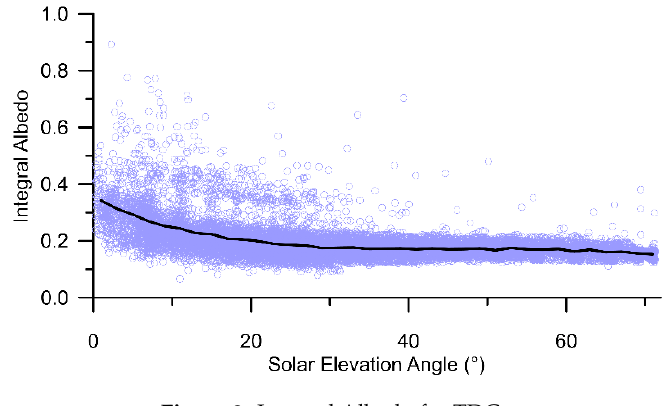
Figure 3. Integral Albedo for TDCs.